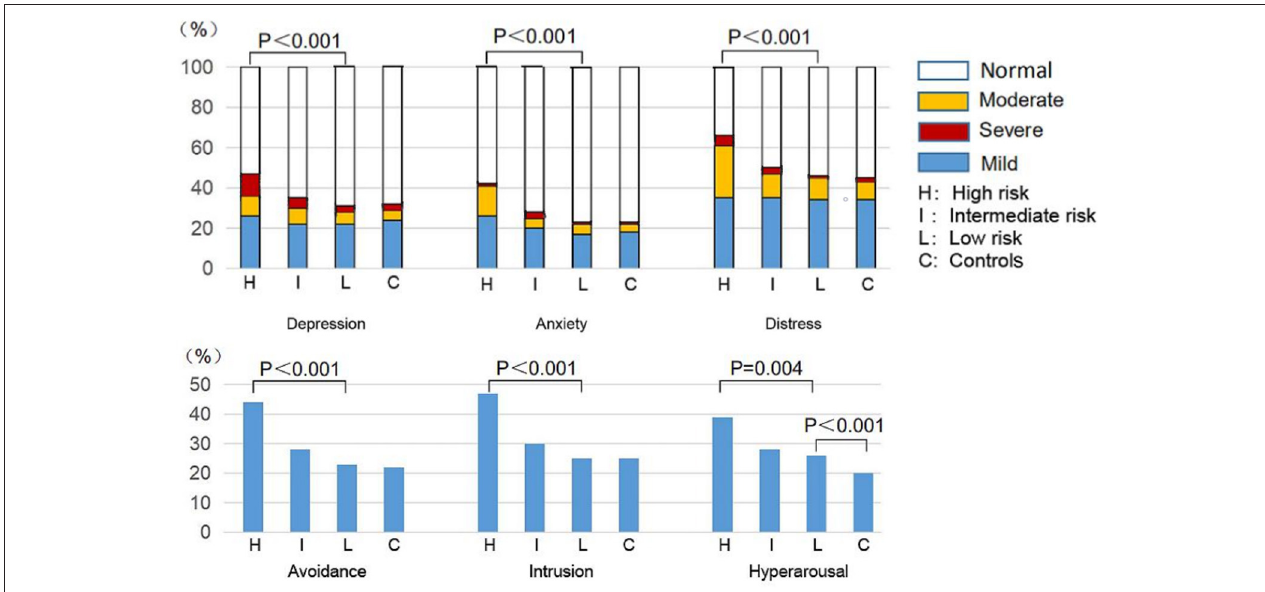
FIGURE 2 | Comparison of mental health among the subgroups with CML and controls.